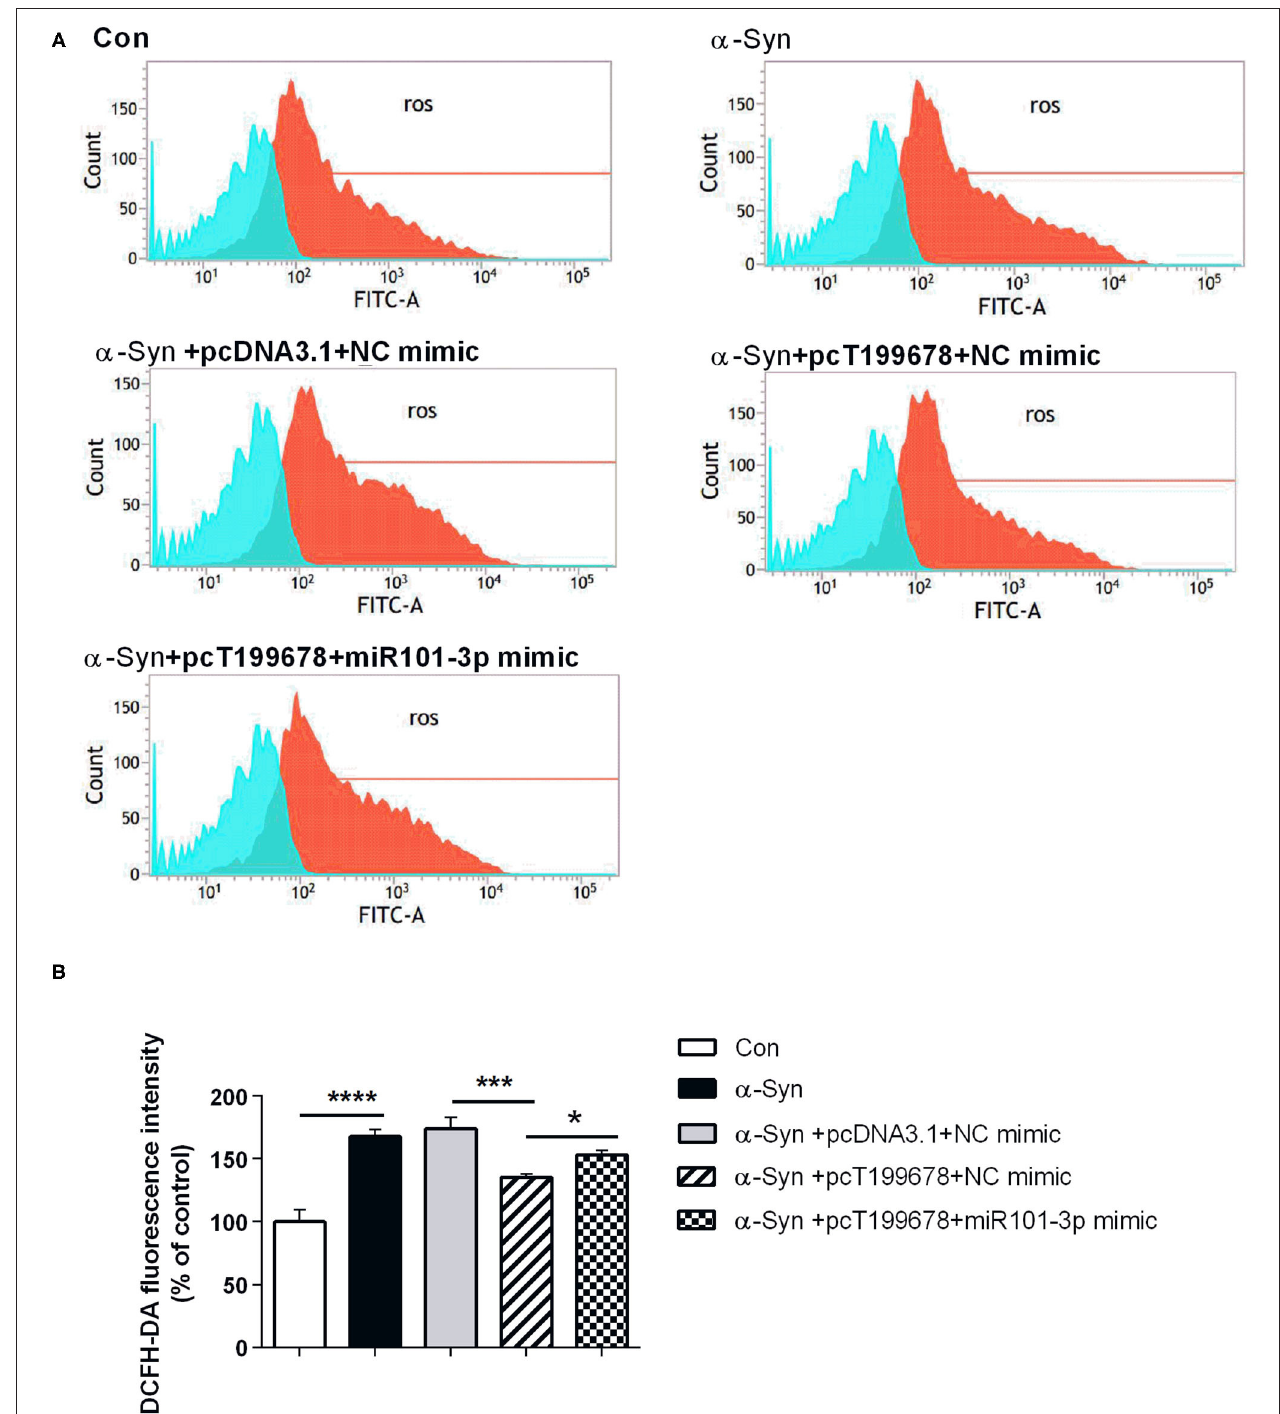
FIGURE 6 | Overexpression of lncRNA-T199678 decreased the ROS production that was affected by α -Syn through miR-101-3p. SH-SY5Y cells were divided into five groups: control (wild type), α -Syn, α -Syn + pcDNA3.1 + NC mimic, α -Syn + pcT199678 + NC mimic, and α -Syn + pc T199678 + miR-101-3p mimic. (A) The oxidative stress (level of ROS) was detected by flow cytometry. (B) Fluorescence of DCFH-DA was detected by flow cytometry (one-way ANOVA, F = 60.30, df = 14, P < 0.0001, followed by Tukey’s multiple-comparison tests: control vs. α -Syn, **** P < 0.0001; α -Syn + pcDNA3.1 + NC mimic vs. α -Syn + pcT199678 + NC mimic, *** P < 0.001; α -Syn + pcT199678 + NC mimic, α -Syn + pc T199678 + miR-101-3p mimic, * P <